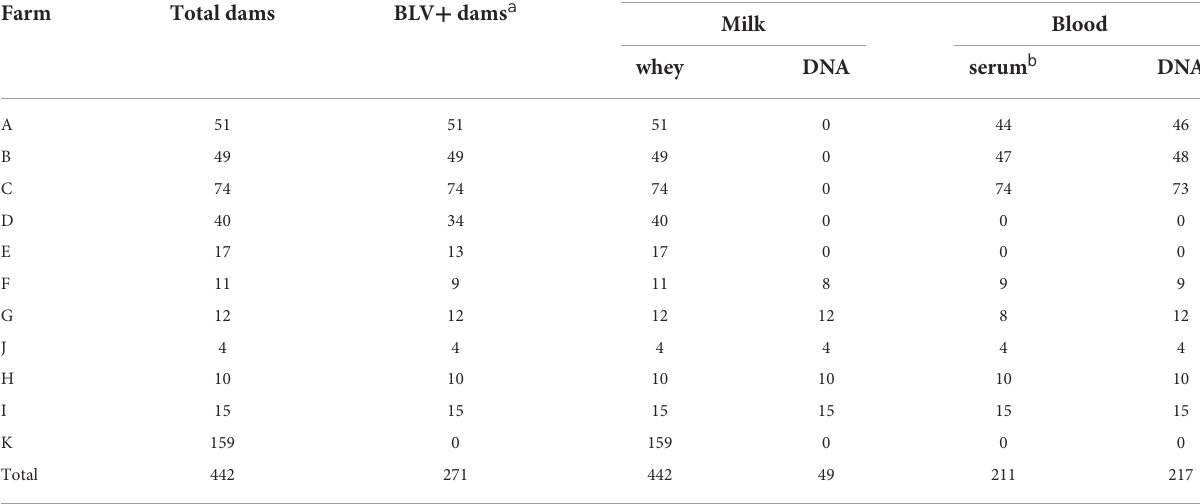
TABLE 1 Bovine leukemia virus (BLV) prevalence and sample number and for each farm. Farm Total dams BLV + dams a